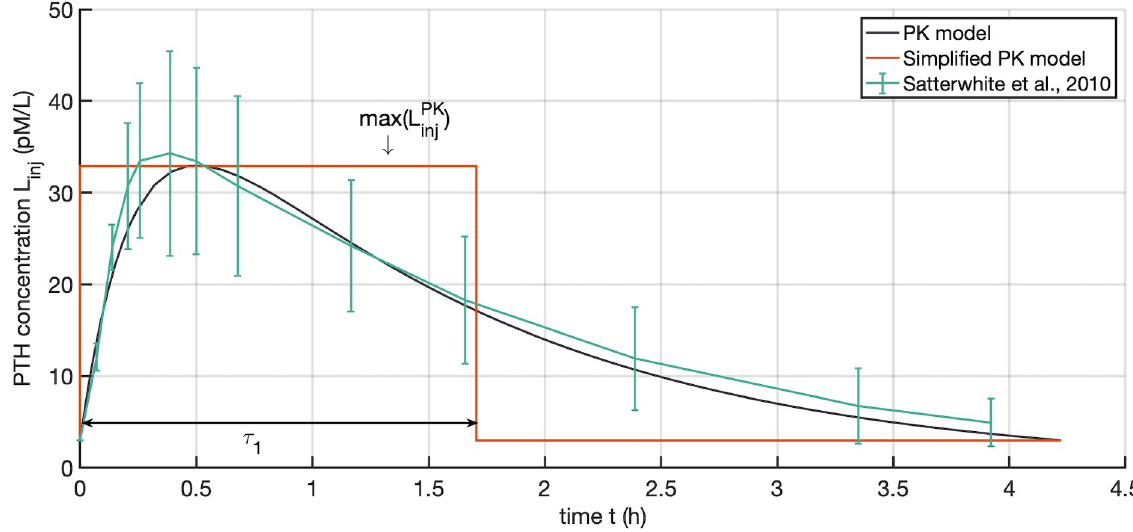
Fig 3. PTH plasma concentration obtained from the PTH PK model and the simplified square-wave stimulus characterised by the maximum PTH concentration max ð L PK Þ and the on-phase τ 1 inj